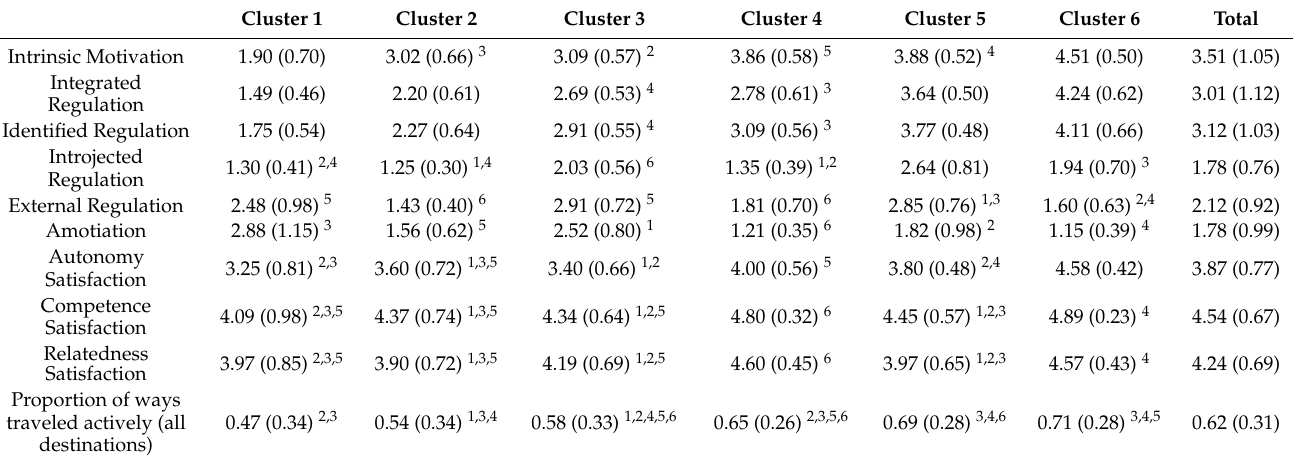
Table 1. Means (standard deviation) and pairwise comparison of SOM input variables and proportion of ways traveled actively for all six clusters and for the total sample.